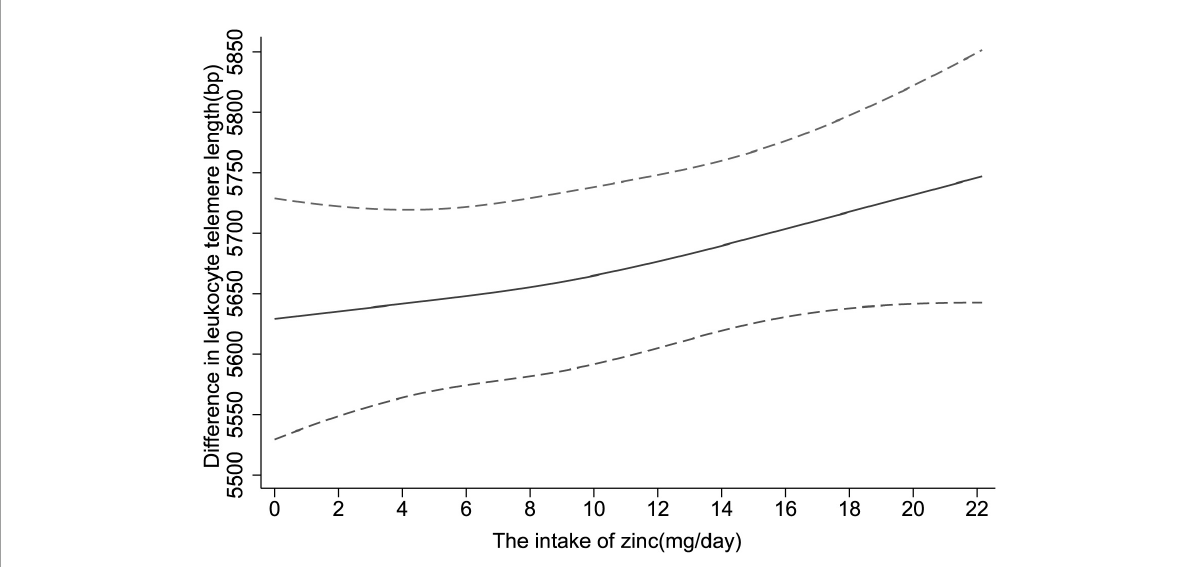
FIGURE2 The dose-response relationship between dietary zinc intake and telomere length. Point estimates (solid line) and 95% confidence intervals (dashed lines) were estimated by restricted cubic splines analysis with knots placed at the 5th, 50th, and 95th percentile (minimum as